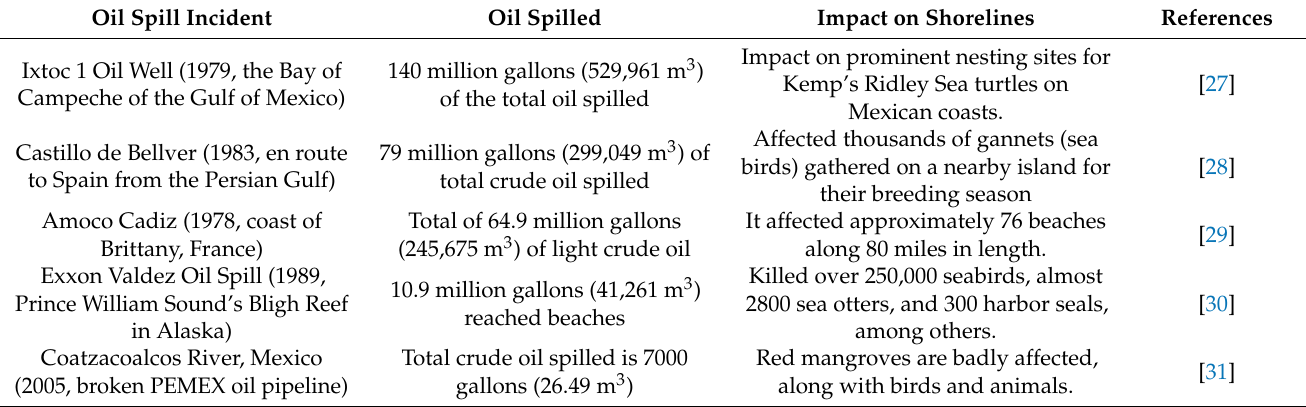
Table 1. Examples from past major oil spill events and their impact on